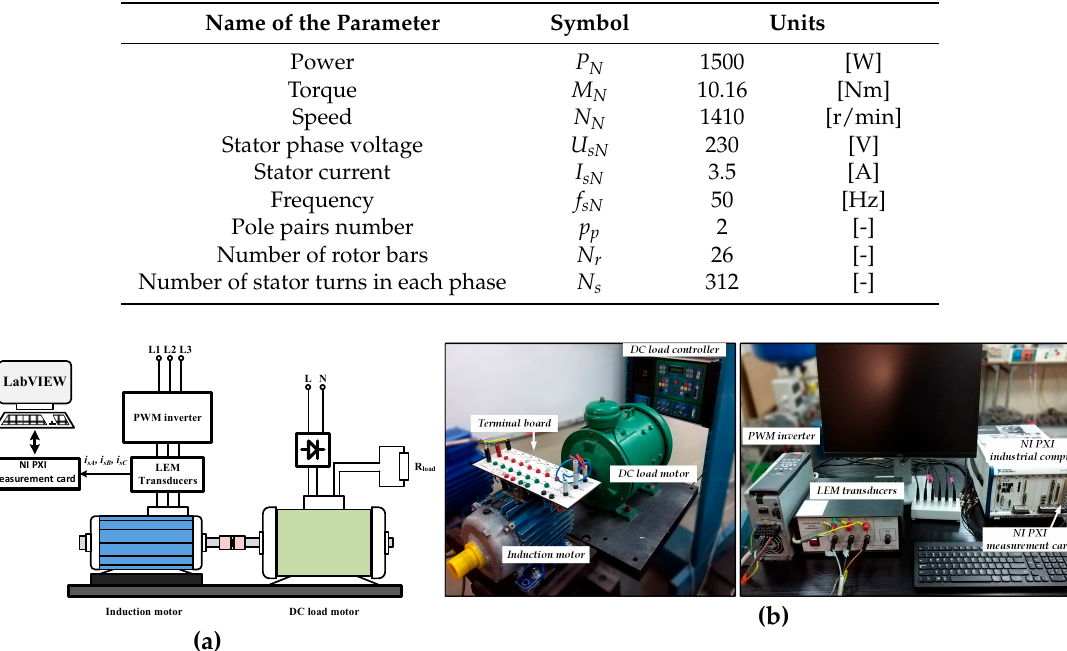
Figure 3. Experimental setup: ( a ) block diagram; ( b ) real view. PWM: pulse width modulation.